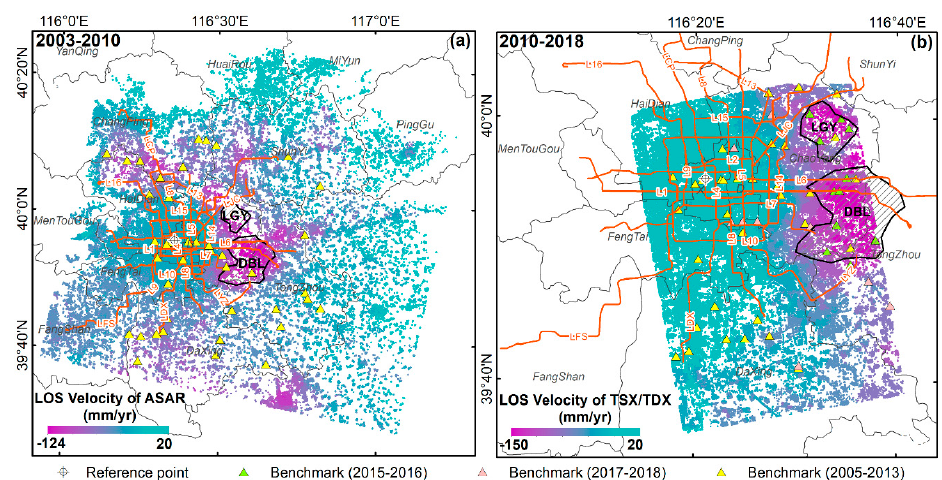
Figure 3. The deformation rates obtained by MTI for two kinds of SAR data: ( a ) ASAR, ( b ) TSX / TDX. The colored triangles indicate the location of the leveling benchmarks. The black crosses indicate the reference points selected by each data source for deformation monitoring. The coordinates of reference points are: ( a ) 116.358E, 39.926N and ( b ) 116.350E, 39.922N. The orange lines represent the Beijing subway network distribution in 2018.